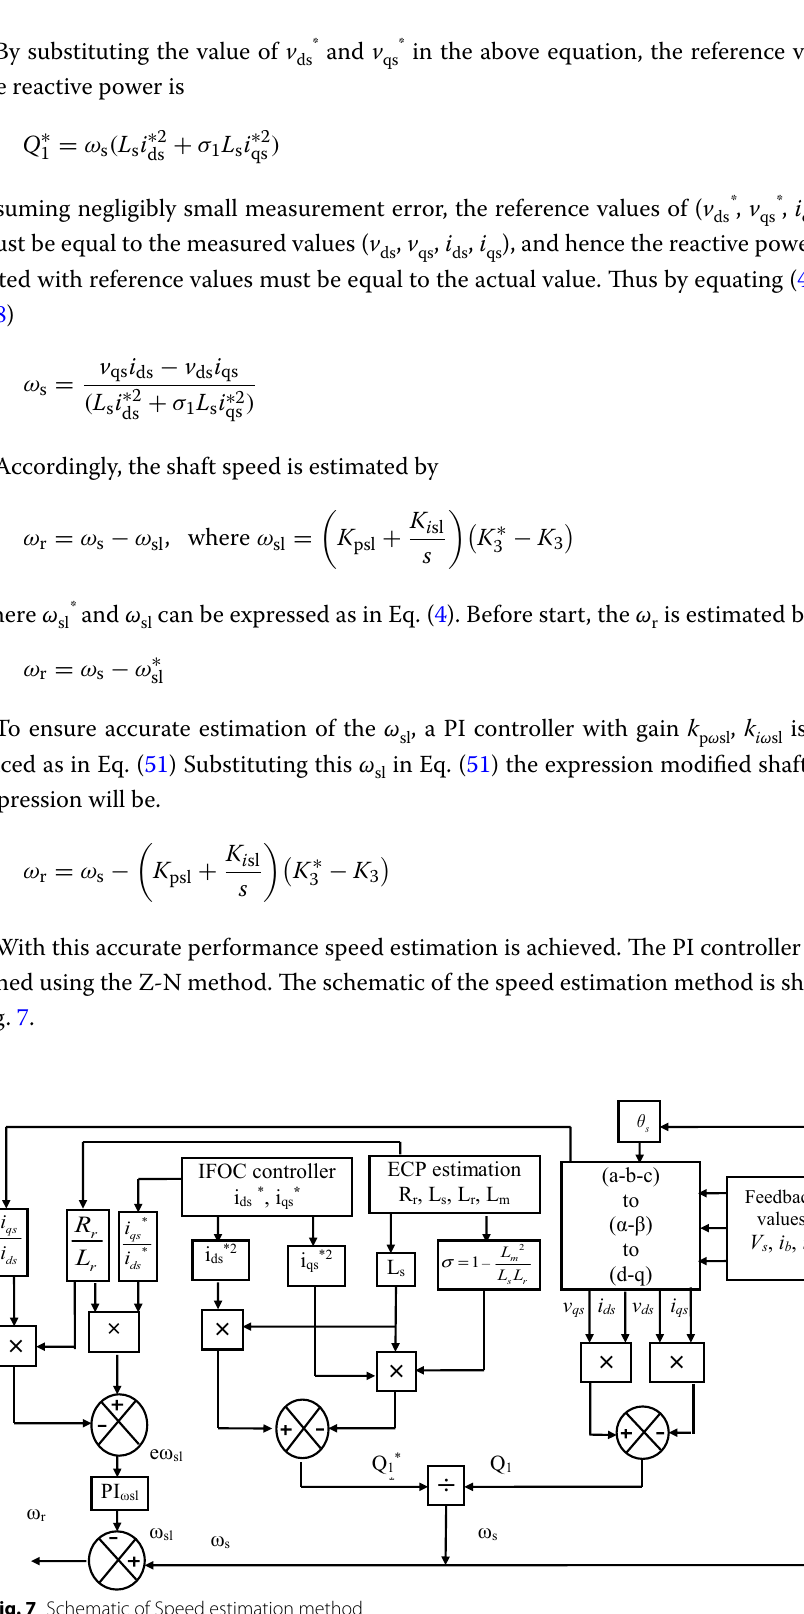
Fig. 7 Schematic of Speed estimation